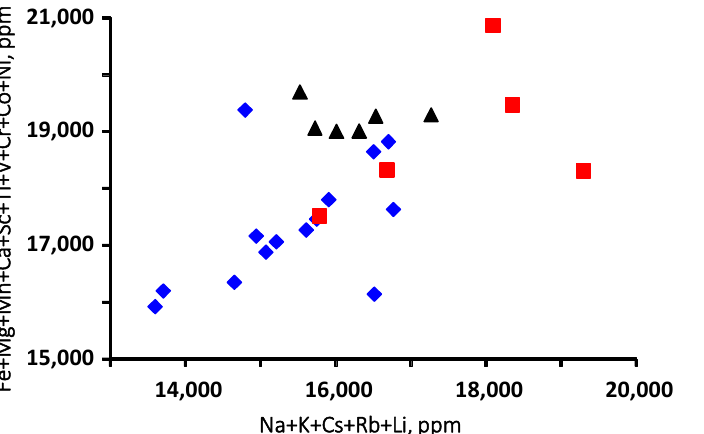
Figure 8. Correlation between transition+Ca+Mg and alkaline+light elements in the analyzed zon- Figure 8. Binary diagram shows the correlation between transition+Ca+Mg and alkaline+light ing of beryl from Wadi Nugrus, South Eastern Desert, Egypt. Symbols are the same as in Figure 5: elements in the analyzed zoning of beryl from Wadi Nugrus, South Eastern Desert, Egypt. Symbols red square for bright-green rim (spots 1–5), black triangle for pale-green rim (spots 20–25) and blue are the same as in Figure 5: red square for bright-green rim (spots 1–5), black triangle for pale-green lozenge for brown-green core (spots 6–19) of beryl crystal. rim (spots 20–25) and blue lozenge for brown-green core (spots 6–19) of beryl